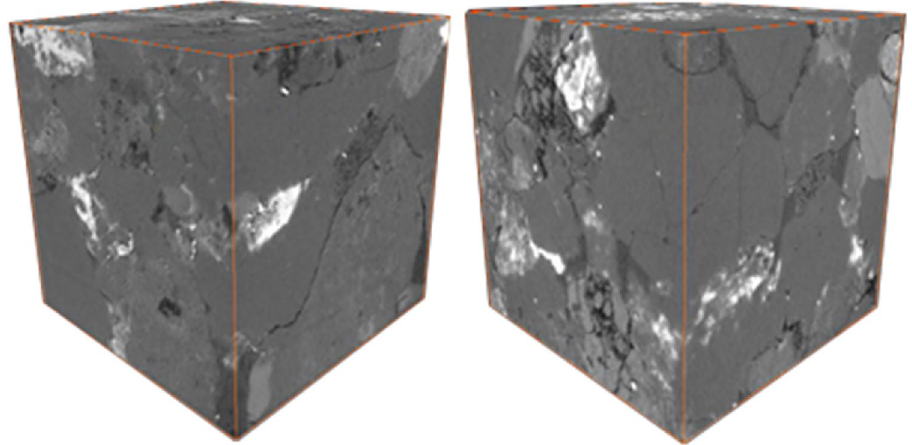
Fig. 3 3D grayscale image of No. 1 andNo. 2 rock samples from well Ybei X